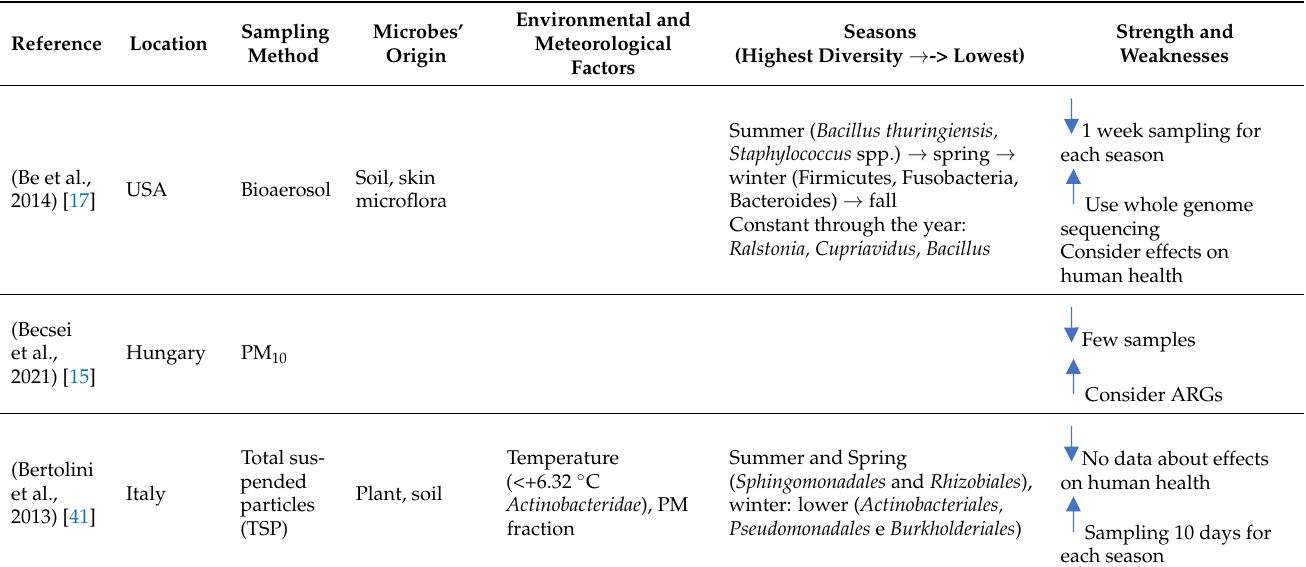
Table 2. Parameters that affect the microbial community: microorganisms’ emission sources, environmental and meteorological factors, and the season in which the alpha diversity was higher reported by each selected paper. Strength (indicated with ) and criticalities ( ) for each paper are reported.